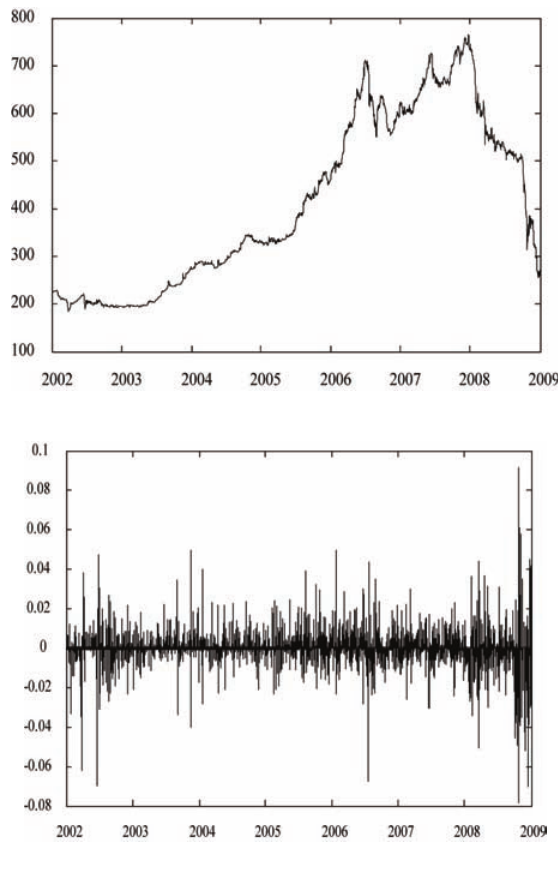
Fig. 3. RIGSE Index Values and Return, Period